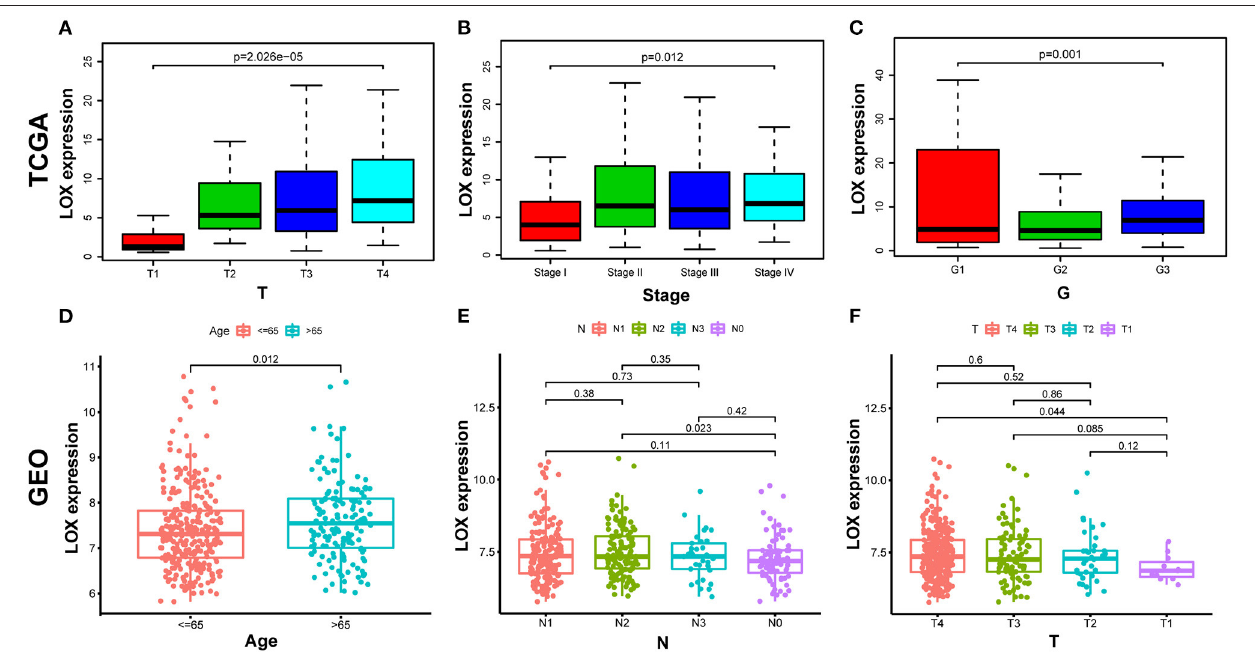
FIGURE 3 | The relationship between LOX expression and clinicopathological characteristics. (A–C) Analyze the relationship between LOX expression and T stage, clinical-stage, and histologic grade based on TCGA data. (D–F) Analyze the relationship between LOX expression and Age, T stage and N stage based on GEO data. (Wilcoxon or Kruskal-Wallis test). TCGA, The Cancer Genome Atlas; GEO, the Gene Expression Omnibus.